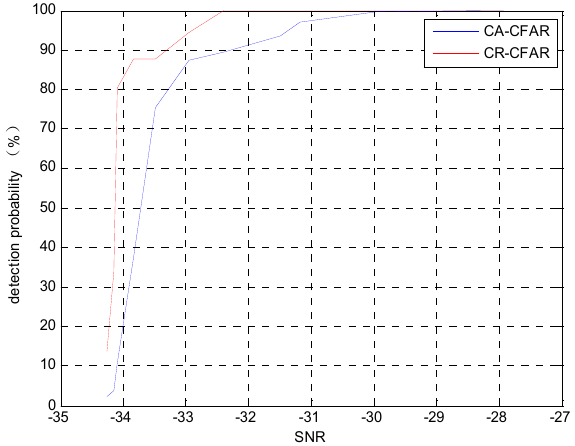
Figure 5. Performance comparison of CA-CFAR and CR-CFAR.